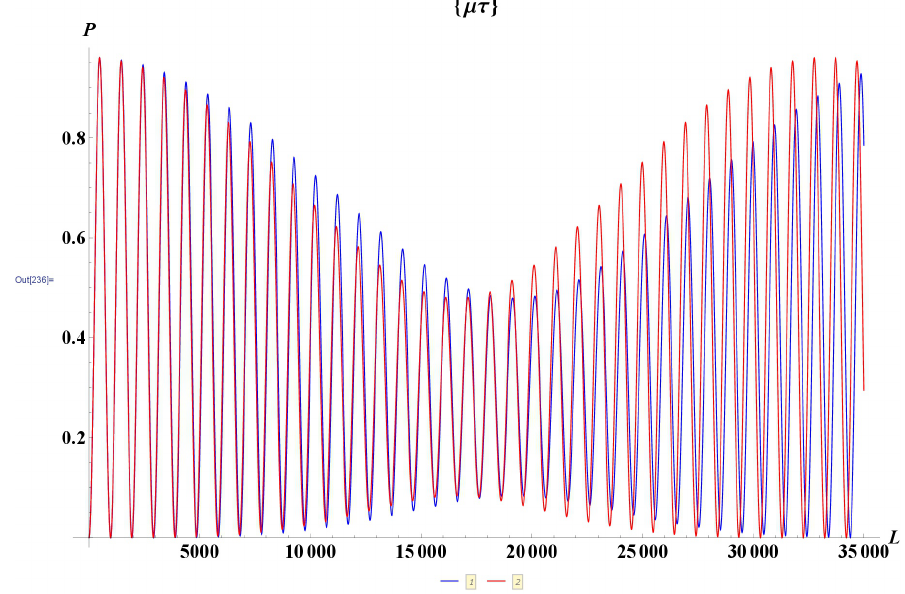
Figure 2. Same analysis of Figure 1, but for the oscillation ν µ → ν τ . Baseline L in km